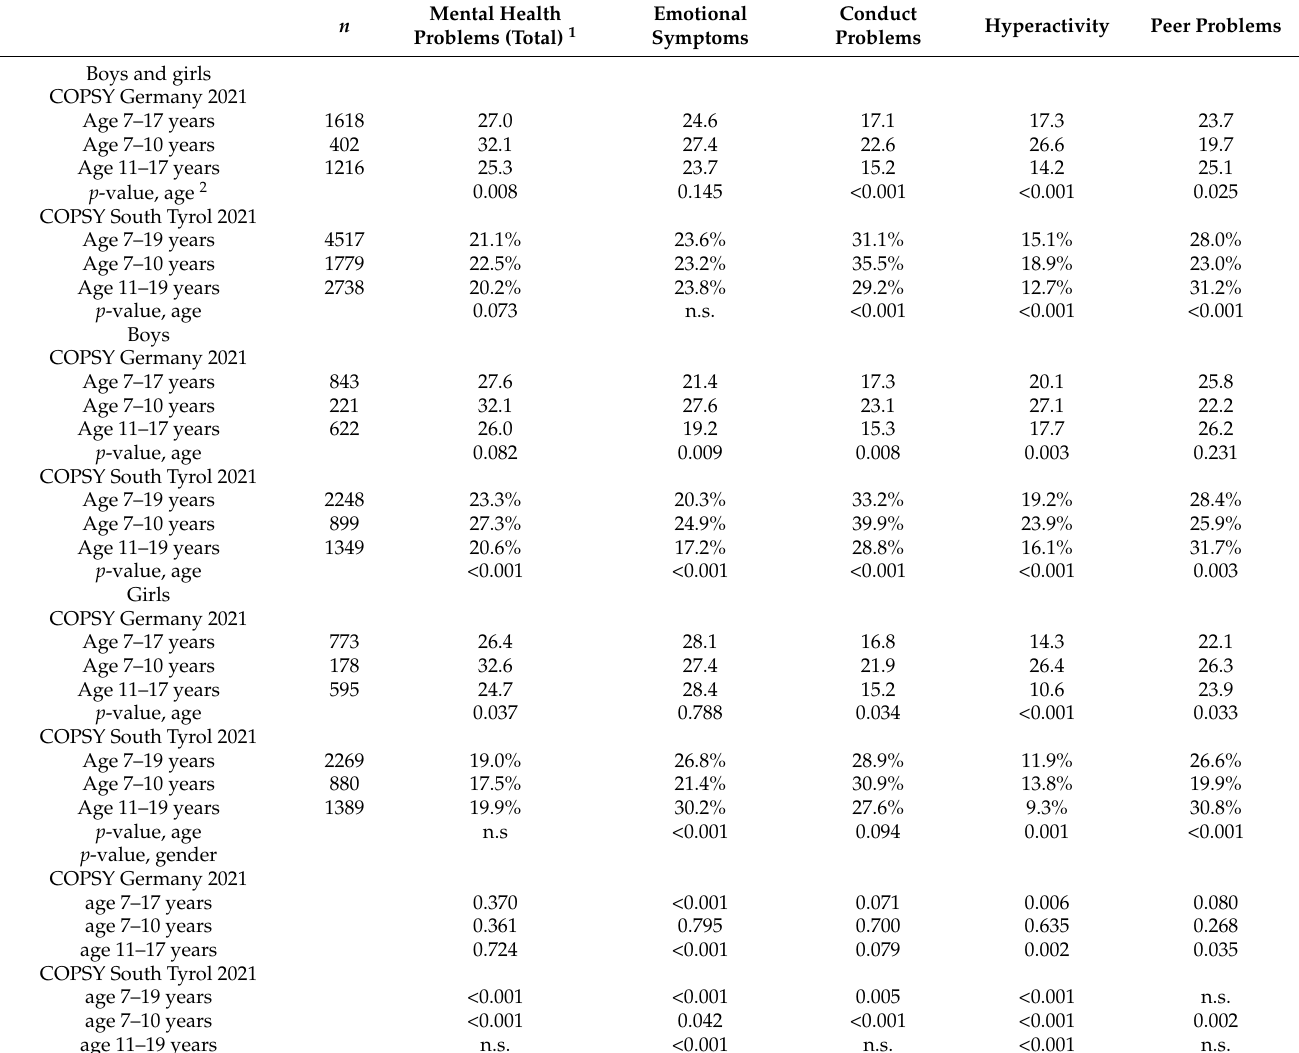
Table 3. Prevalence of parent-reported mental health problems in children and adolescents in the second year of the COVID-19 pandemic in Germany and South Tyrol, stratified by gender and age. Mental Health Emotional n Problems (Total) 1